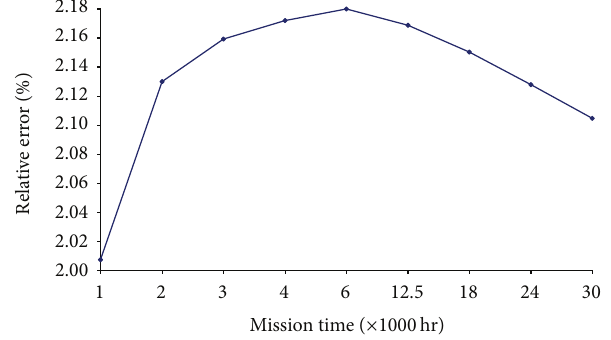
Figure 5: Variation of relative error with mission